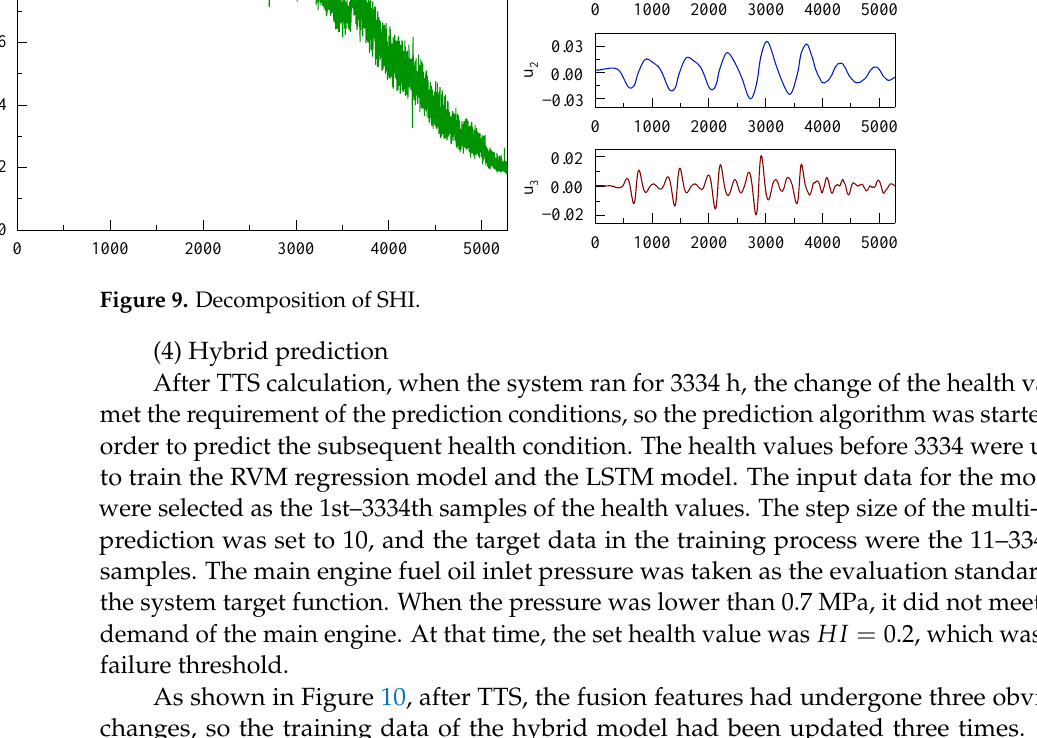
Figure 10. Hybrid prediction of system health condition. 4.2.2. RUL Prediction with Disturbance There were many influencing factors in the actual system, and the health condition changed dynamically, so it was difficult to accurately evaluate the RUL of the system in one prediction. For example, there was redundant equipment in the system, and equip- ment switching would lead to a substantial recovery of function. Obviously, if the previ- ous prediction method is used, the error could be very large. Therefore, it was necessary